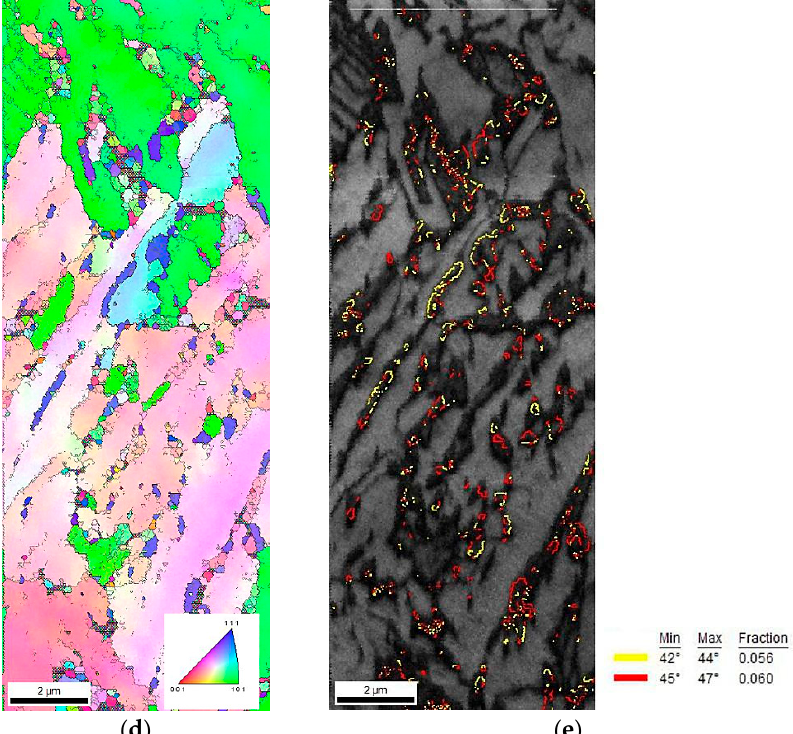
Figure 8. Image of the 3Mn-1.5Al steel deformed to 5% strain; IQ map ( a ), phase distribution map (retained austenite as red) ( b ), low-angle (2 ◦ –15 ◦ —thin line) and high-angle (15 ◦ –180 ◦ —thick line) boundaries map ( c ), inverse pole figure ( d ), grain boundaries of austenite and martensite/bainitic ferrite showing the Kurdjumov–Sachs (yellow) and Nishiyama–Wasserman (red) crystallographic relationships ( e ).